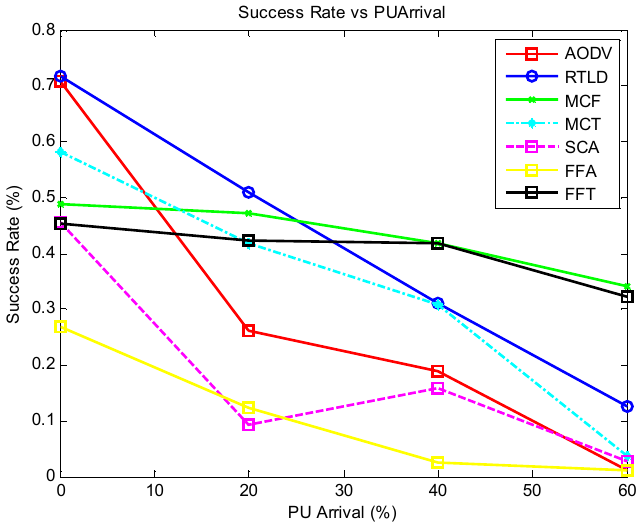
Figure 6. Success rate of all protocols versus primary user activity.